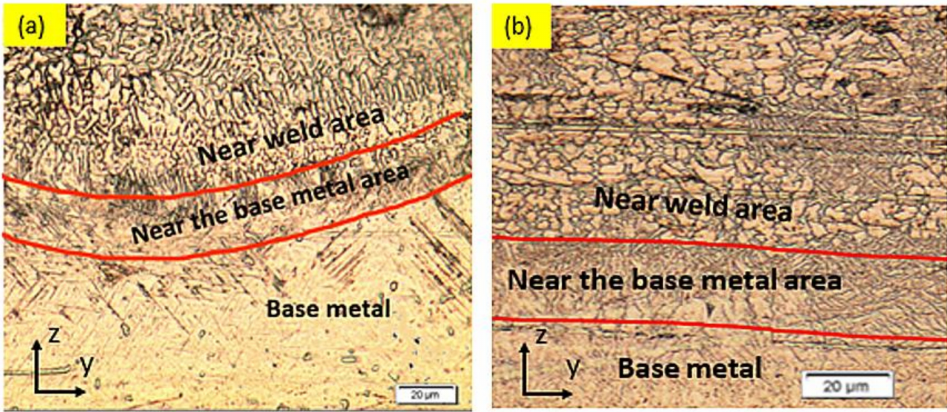
Figure 8. The microstructures of HAZ Ti6Al4V welded ( a ) in serum medium ( b ) in air medium. The laser parameters, such as the focal position and the laser power, have a solid impact on the welding quality. The SPE value can be used to investigate the total impact of laser parameters. The influence of the focal position was examined by varying it from − 6 mm to − 3 mm while other parameters were kept constant (5 mm/s speed, 11 J energy, 20 Hz frequency, and 5 ms pulse duration), with results given in Figure 9. When the distance between the laser head and WM is close enough ( − 3 mm), the highest penetration depth was achieved for both media (air and serum). Although the depth of penetration is different for various focal position values, for the − 3 mm focal position the penetration depth value is almost the same, achieving the maximum value (this value was 900 µ m for both media, as shown in Figure 9). As the laser radius increases, the amount of